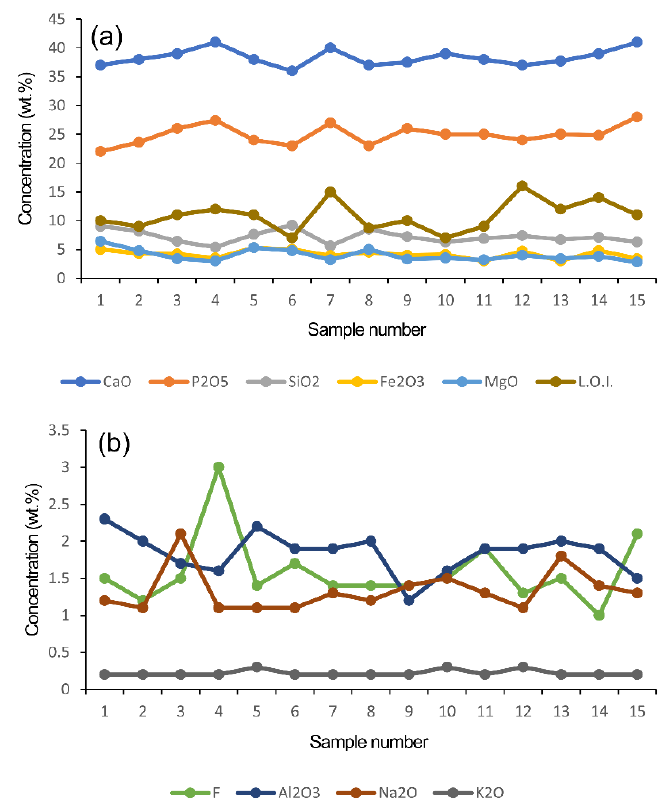
Figure 4. ( a , b ) Distribution curves of the major oxides (wt.%) in phosphorite Figure 4. (a , b ) Distribution curves of the major oxides (wt.%) in phosphorite samples. Table 2. Comparison of the examined major oxides (wt.%) of Qulu El Sabaya phosphorites with some Egyptian phosphorites.